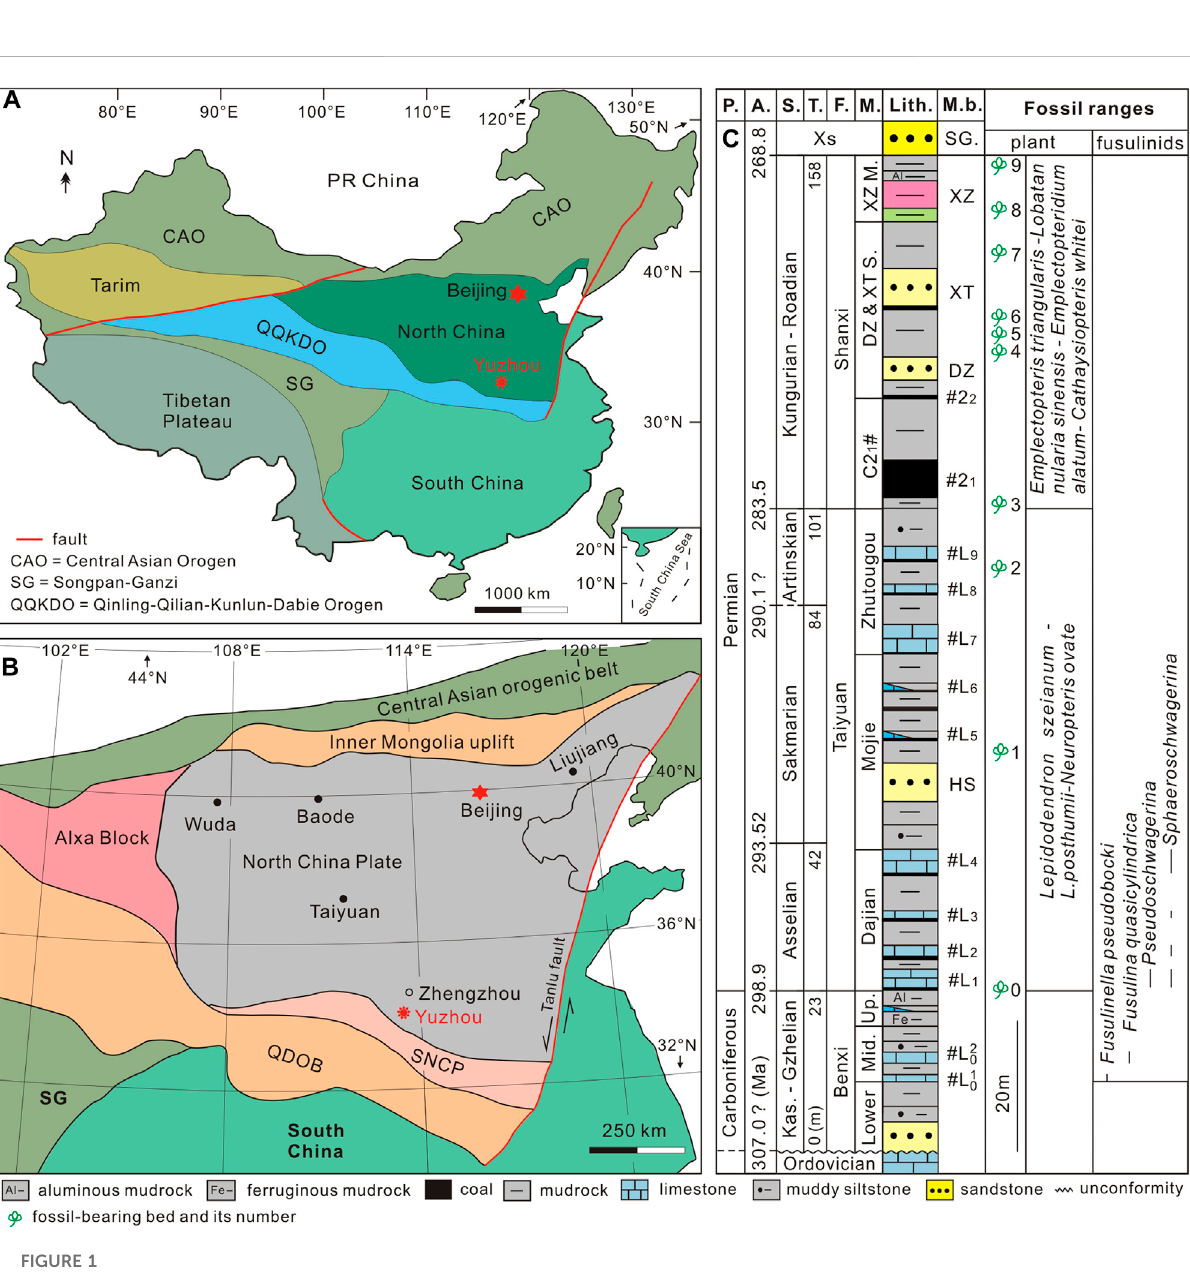
coals. The Xiaozi Member also represents an important regional lithostratigraphic marker (Figure 1C) (Yang and Lei, 1987).